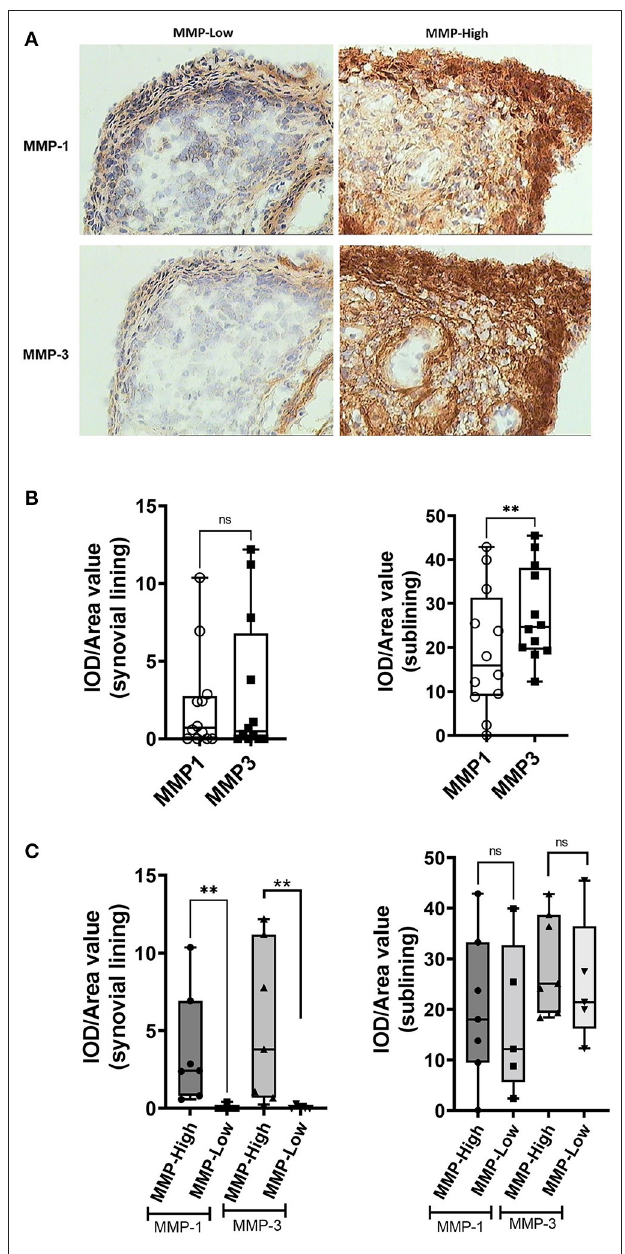
FIGURE 2 | Analysis of MMP-1 and MMP-3 protein expression in the synovium of DMARD-naïve EIA patients— (A) Representative images showing immunohistochemical staining of MMP-1 (upper) and MMP-3 (lower) in the OCT-embedded tissue sections of MMP-low and MMP-high groups. (B) Box-whiskers plot showing quantification of MMP-1 and MMP-3 IHC staining in the synovial lining and sublining of DMARD-naïve EIA patients. Data was presented as IOD/area value indicating relative expression and analyzed by Mann-Whitney test. ** P < 0.01, ns, non-significant (C) Box-whiskers plot showing quantification of MMP-1 and MMP-3 IHC staining in the synovial lining and sublining of MMP-low and MMP-high DMARD-naïve EIA patients. Data was presented as IOD/area value indicating relative expression and analyzed by Mann-Whitney test. ** P < 0.01, ns, non-significant; IOD, integrated optical